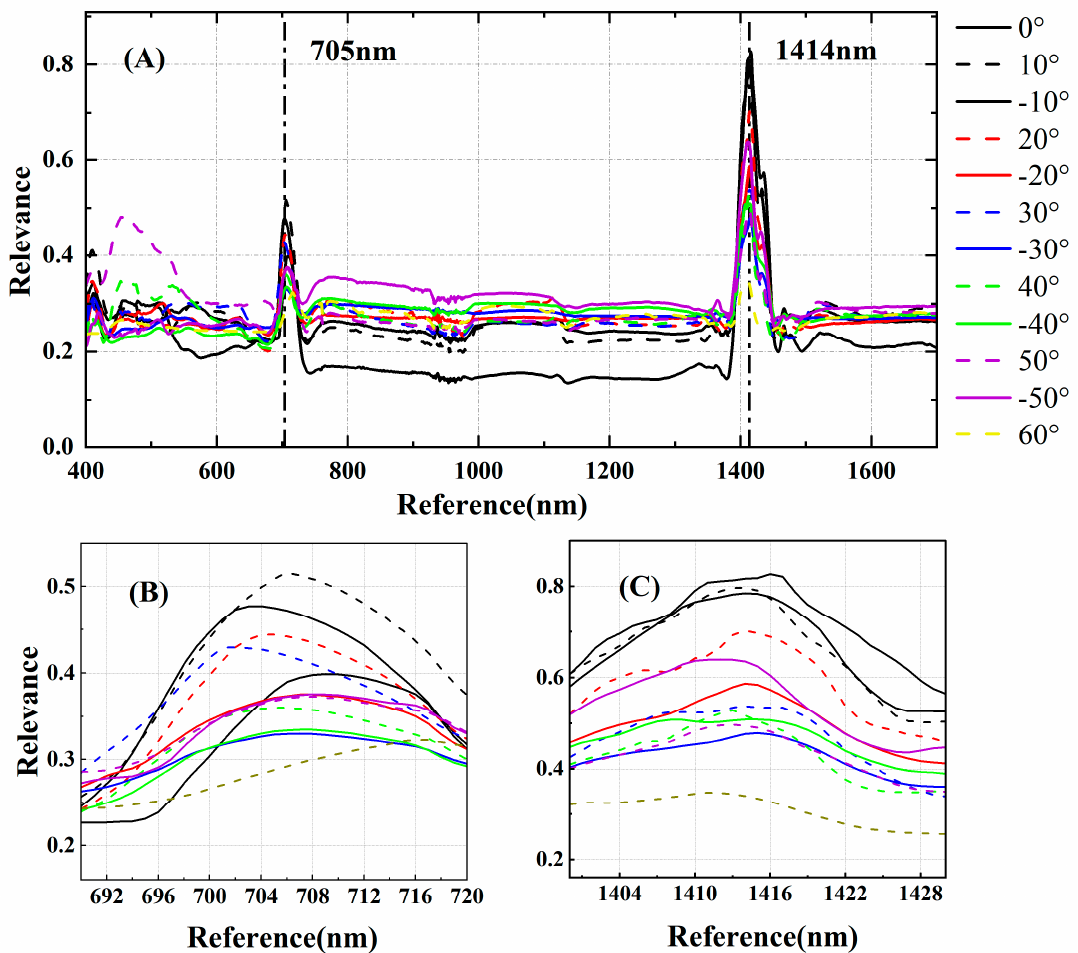
Figure 5. Based on the Relief-F algorithm, the single-wavelength weight value of ANC with cotton under different VZAs was evaluated. ( A ) Single-wavelength weight value with cotton ANC under different VZA, ( B ) Weight value of ANC near 705 nm and cotton under different VZA, ( C ) Weight value of ANC near 1414 nm and cotton under different VZA.